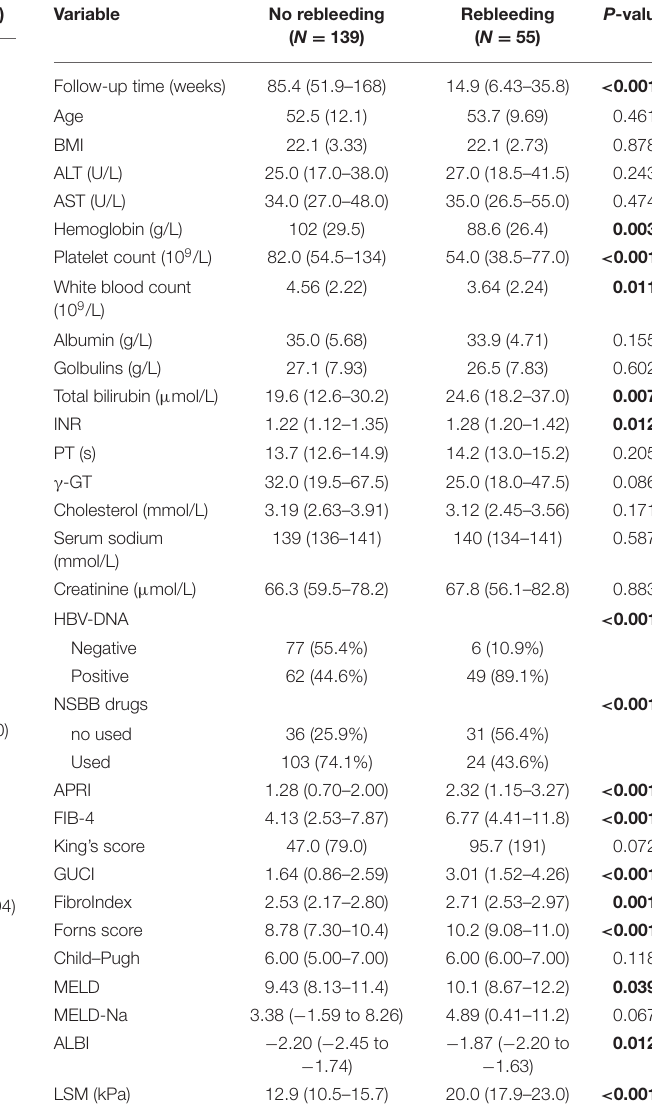
TABLE 1 | Baseline characteristics of patients. TABLE 2 | Characteristics between the no rebleeding group and rebleeding